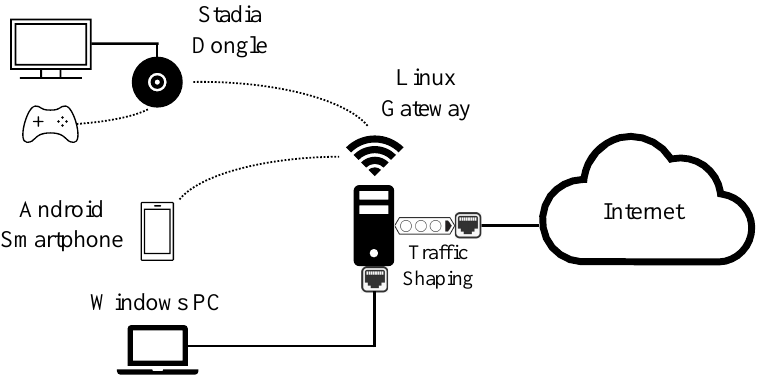
Figure 1. Testbed used for the experimental